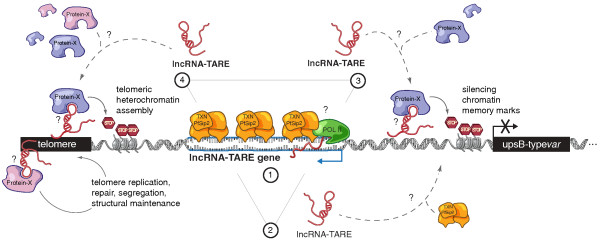
Potential models for lncRNA-TARE at P. falciparum chromosome ends. Model 1: PfSip2 binding at SPE2 sites induces lncRNA-TARE transcription and/or vice versa. Model 2: lncRNA-TARE guides multiple copies of PfSip2 to chromosome ends. Model 3: lncRNA-TARE recruits chromatin-remodeling factors to initiate post-S-phase silencing chromatin memory marks at upsB-type var loci. Model 4: lncRNA-TARE facilitates telomeric heterochromatin assembly and/or interacts with telomere-associated proteins. POL II, RNA polymerase II; TXN, transcription factor.